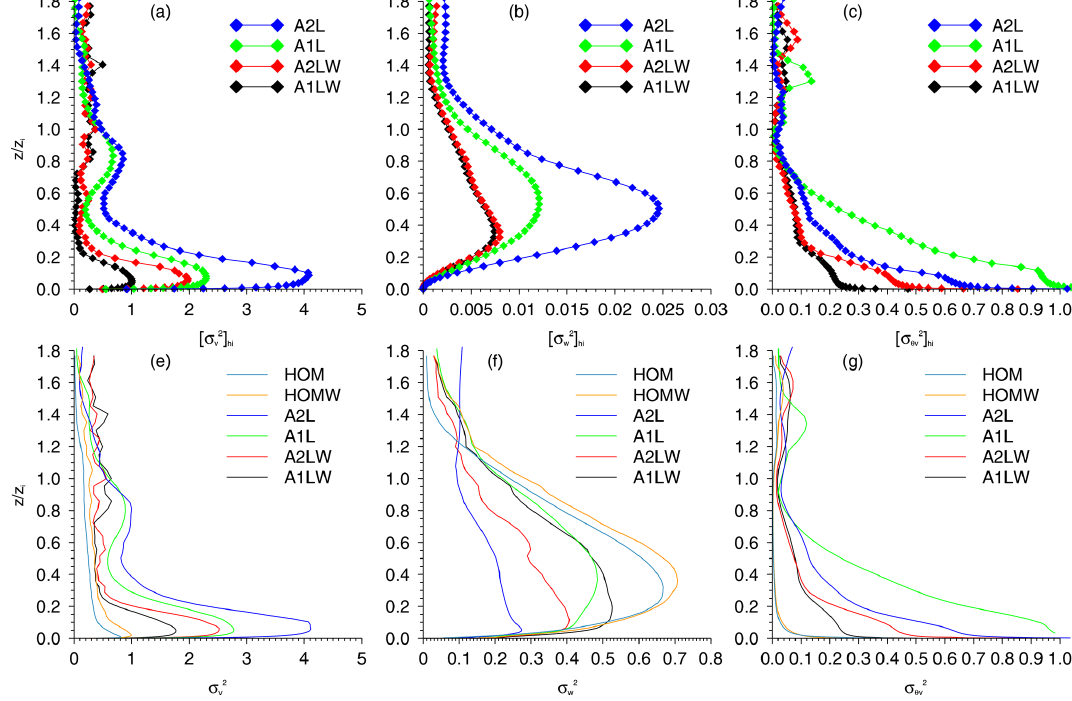
Figure 9. Heterogeneity-induced (a–c) and total (e–g) dimensionless turbulence statistics for runs HOM, HOMW, A1L, A1LW, A2L, and A2LW. Shown are the profiles of the (a, e) v variance, (b, f) w variance, and (c, g) θ